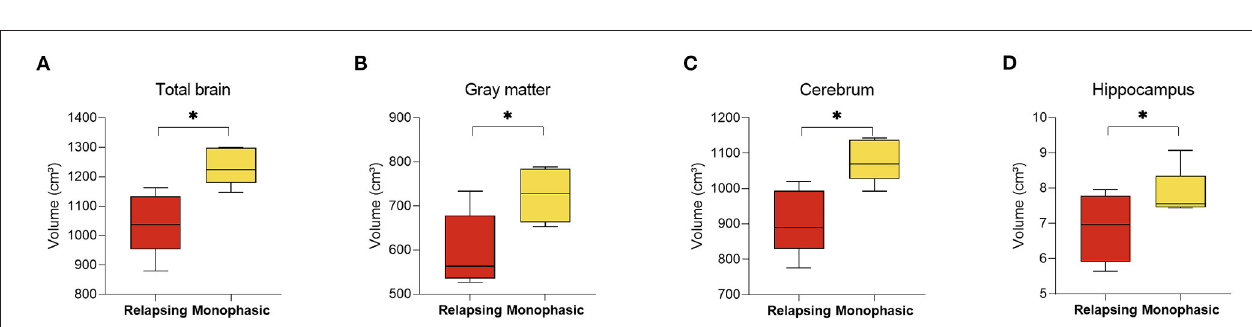
FIGURE 4 | Decreased brain volume in relapsing compared to monophasic MOGAD patients during the first year of diagnosis. Brain volume of relapsing ( n = 5) and monophasic MOGAD patients ( n = 5) during the first year of diagnosis analyzed by Volbrain software. Volume of (A) total brain (1,235.95 ± 64.17 vs. 1,041.76 ± 105.77, p = 0.010), (B) gray matter volume (724.63 ± 61.14 vs. 598.34 ± 83.82, p = 0.038), (C) cerebrum (1,080.29 ± 61.15 vs. 907.26 ± 92.98, p = 0.010), and (D) hippocampus (7.83 ± 0.70 vs. 6.87 ± 0.96, p = 0.044) of monophasic and relapsing course MOGAD patients during the first year of diagnosis. MOGAD, Myelin oligodendrocyte glycoprotein antibody disorders. p * ≤